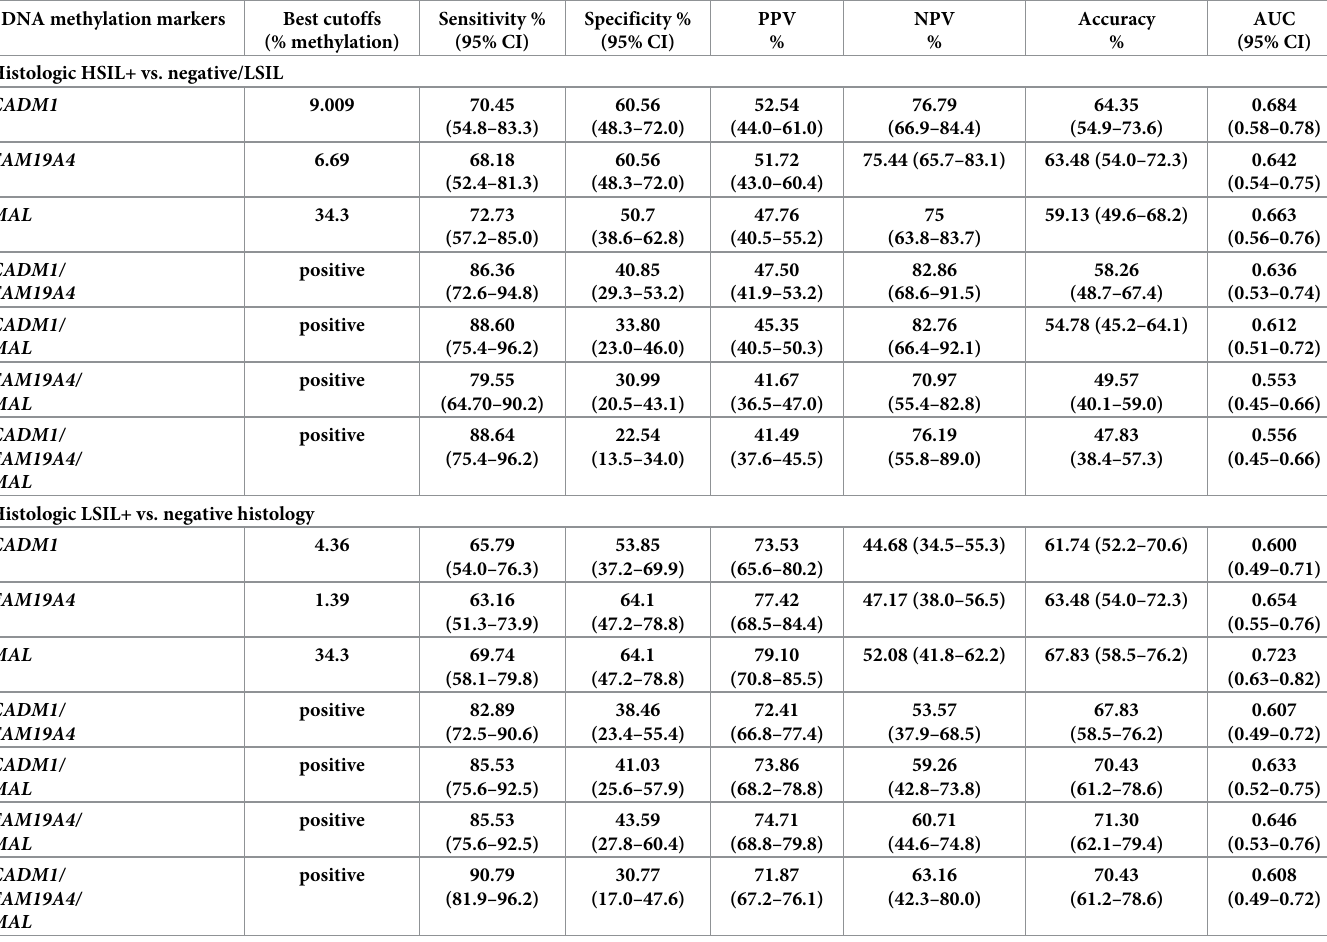
Table 6. The cutoff values of DNA methylation marker for distinguishing high-grade histologic abnormalities (histologic HSIL+ vs. negative/LSIL) and histologic abnormalities (histologic LSIL+ vs. negative histology) in HPV-positive women. DNA methylation